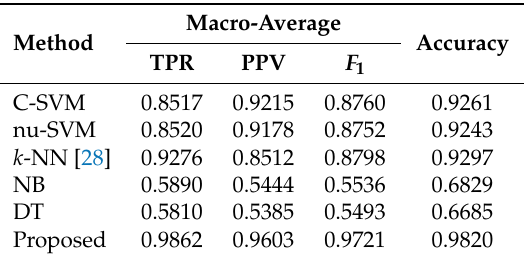
Table 9. Five-fold cross-validation performance comparisons between the proposed ensemble model and five benchmark